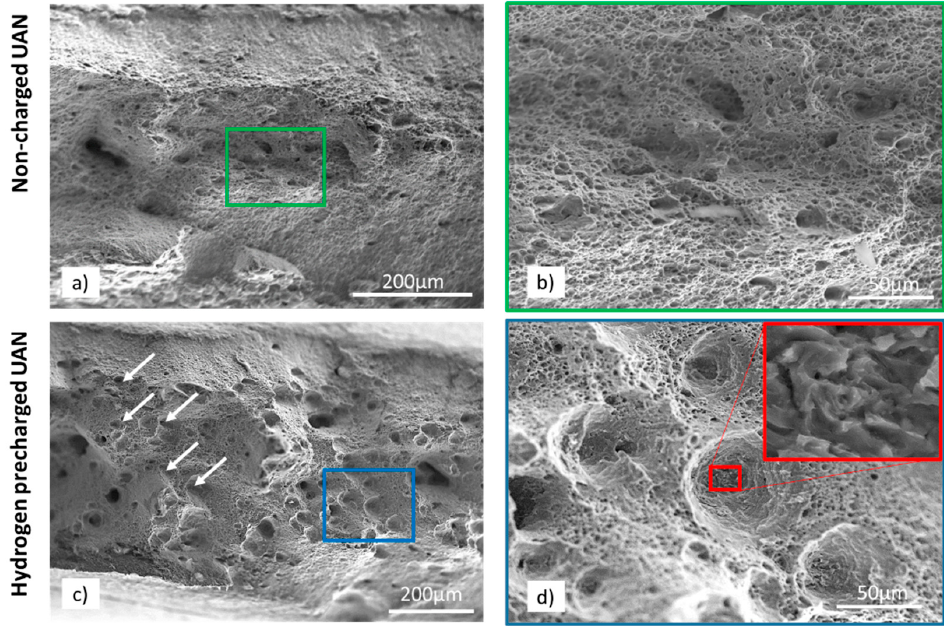
Figure 11. SEM fracture surface of non ‐ charged UAN specimen ( a , b ) and hydrogen ‐ precharged UAN specimen ( c , d ).